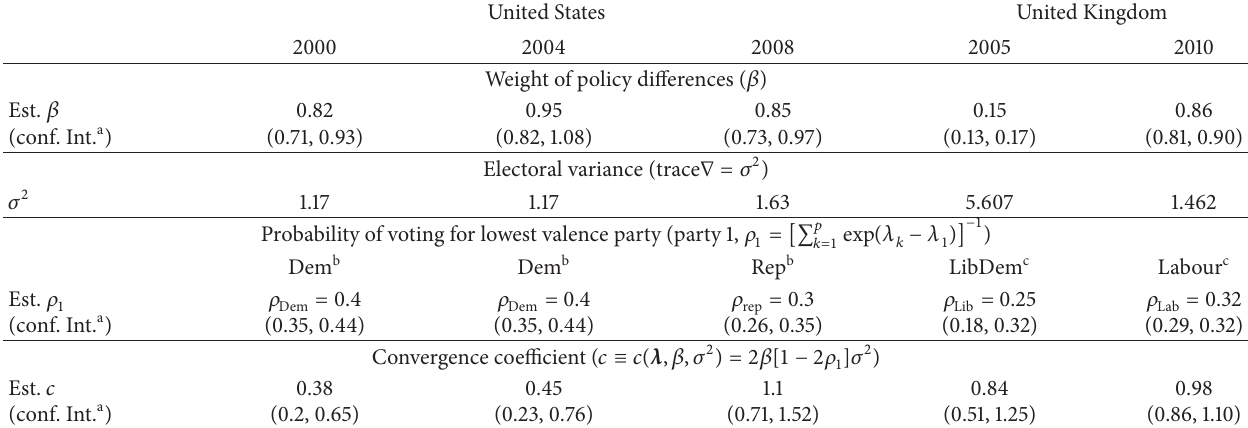
Table 2: The convergence coefficient in plurality